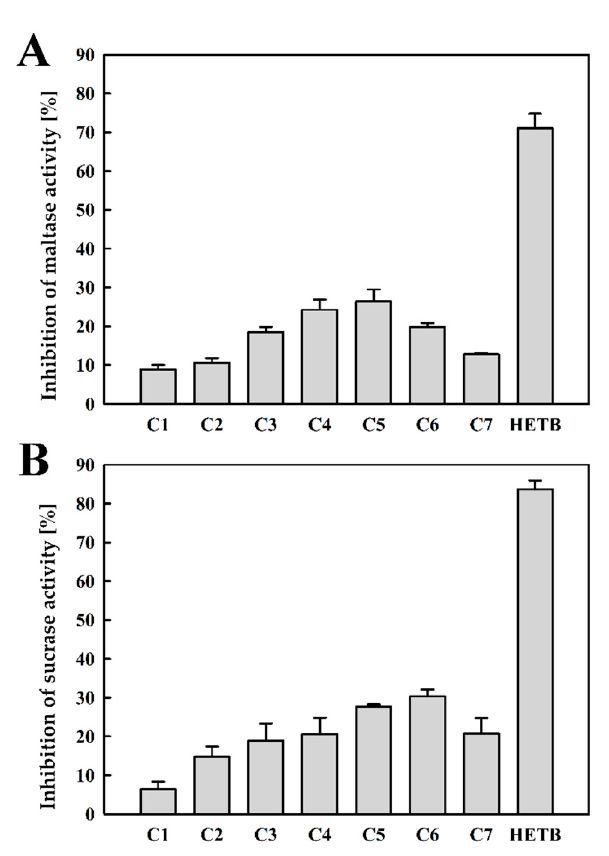
Figure 2. Inhibition of maltase ( A ) and sucrase ( B ) by compounds 1–7 and HETB at concentrations: 50 µ M for maltase inhibition and 40 µ M for sucrase inhibition. Data are presented as means of three independent determinations ± standard deviation (SD).